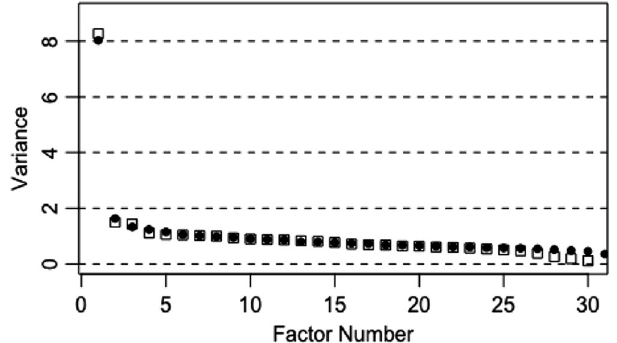
FIG. 6. Scree plots for each of the assessments. The hollow boxes represent the BEMA ’ s eigenvalues and the solid dots represent the CSEM. These plots support the assumption that these assessments can be treated as unidimensional for an IRT model.